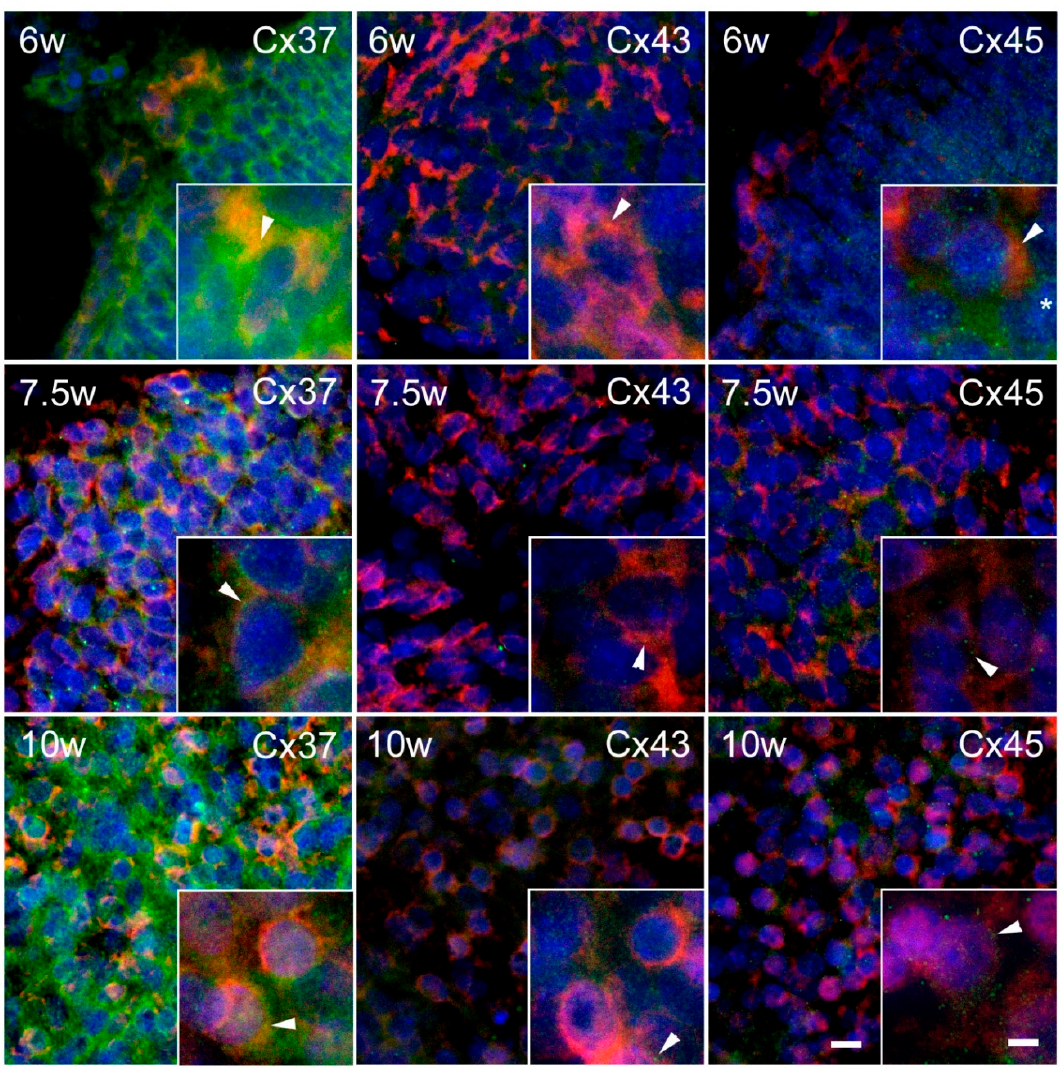
Figure 4. Expression of Cxs 37, 43, and 45 in the ventral part of the intermediate layer of the SC in human conceptuses. Thoracic segments of the SC of 6, 7.5, and 10 week-old human conceptuses were stained for Cx37, Cx43, and Cx45 (green), and PGP9.5 (red). The ventral part of the intermediate layer (VIL), corresponding to the basal plate, was presented on photomicrographs. Objective magnification—40 × (scale bar = 20 µ m); insets—100 × (scale bar = 8 µ m). Arrowheads are pointing to the yellow granular pattern of Cx / PGP9.5 co-localization in the cytoplasm of developing motor neurons. Asterisk—non-neuronal cell, presumably glia, immunoreactive for Cx45.